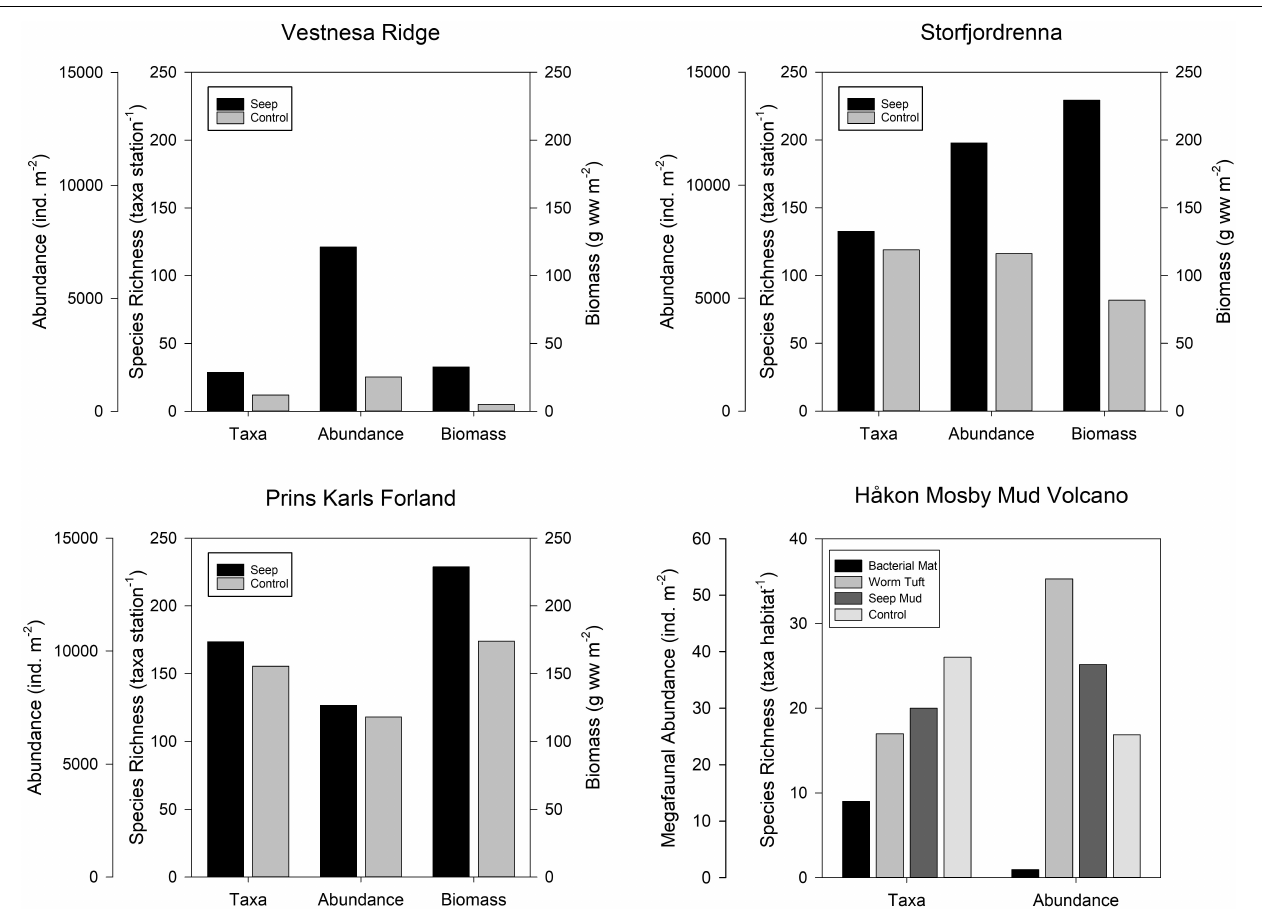
FIGURE 3 | Community faunal parameters [species richness, abundance (density), and biomass] at cold seeps and control areas from four regions in the Arctic where quantitative faunal data are available. Vestnesa Ridge, Storfjordrenna seep, and Prins Karls Forland document macrofaunal infauna, while the Håkon Mosby Mud Volcano is mobile megafauna. Data are compiled from the following sources: Vestnesa Ridge (1,200 m) – Åström et al. (2018), Storfjordrenna (350–390 m) – Åström et al. (2016, 2019), Prins Karls Forland (85–350 m) – Åström et al. (2016), Håkon Mosby Mud Volcano (1,250 m) – Rybakova et al.